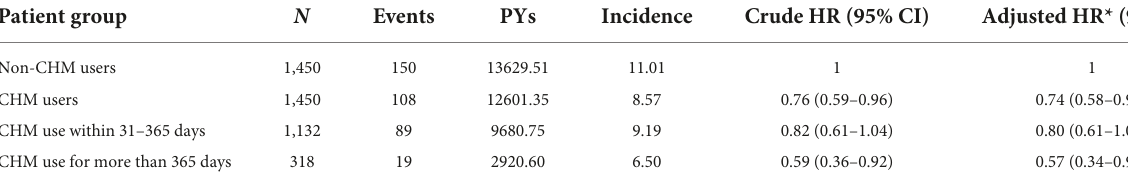
TABLE 2 Risk of depression for breast cancer patients with and without CHM use.